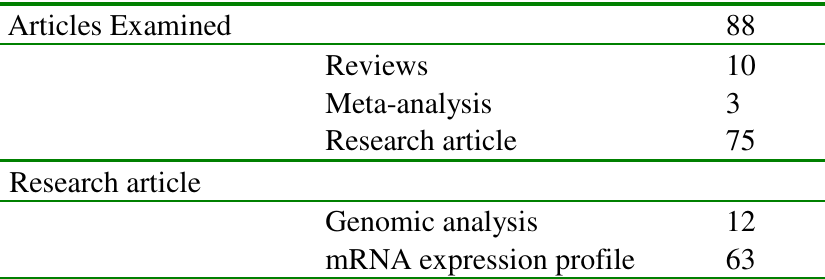
Table 1. Overview: selected literature on